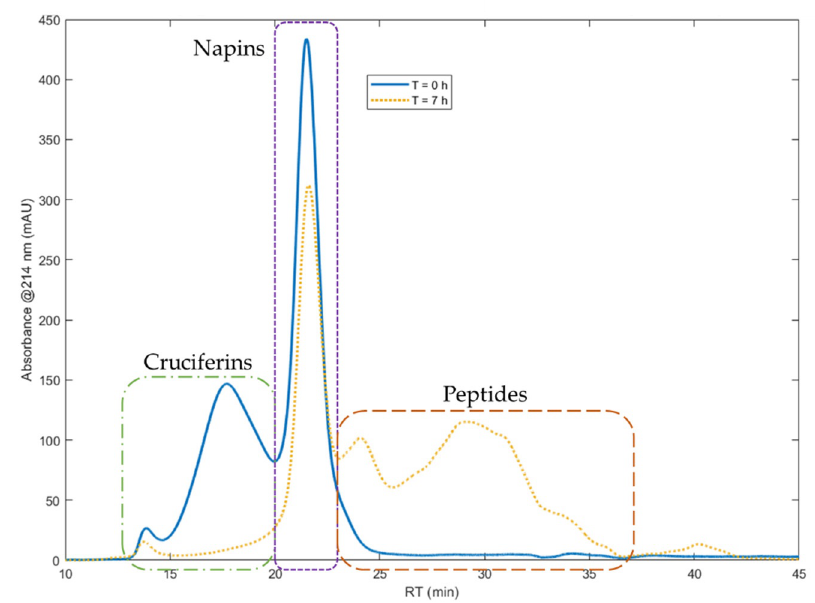
Figure 1. Size exclusion chromatograms of total rapeseed protein isolate at time t = 0 (blue curve) and at time t = 7 h of hydrolysis reaction with the protease Prolyve ® (yellow curve). Chromatographic system: Superdex Peptide 10/300 GL column, detection at 214 nm, solvent: water/acetonitrile/TFA (69.9/30/0.1), flow rate of 0.5 mL min − 1 .